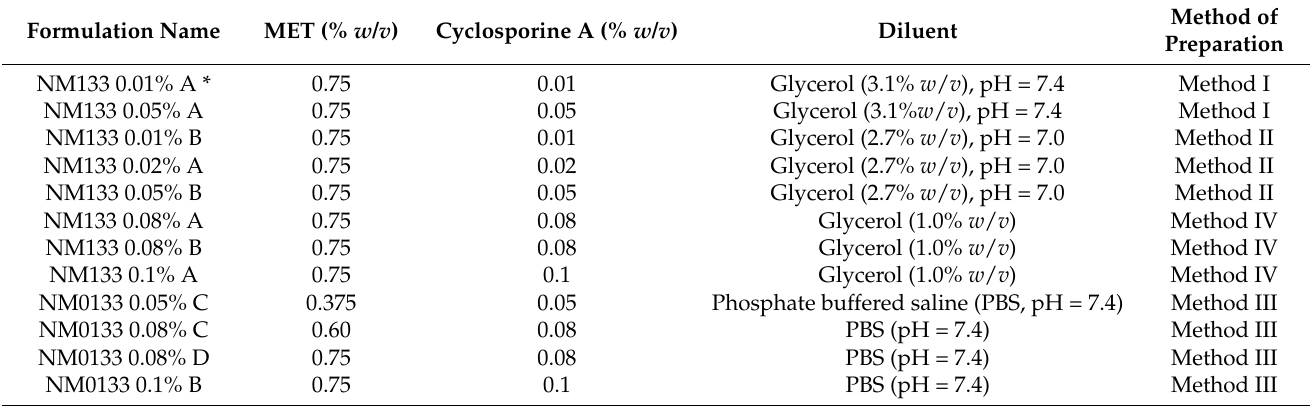
Table 1. NM133 Formulations